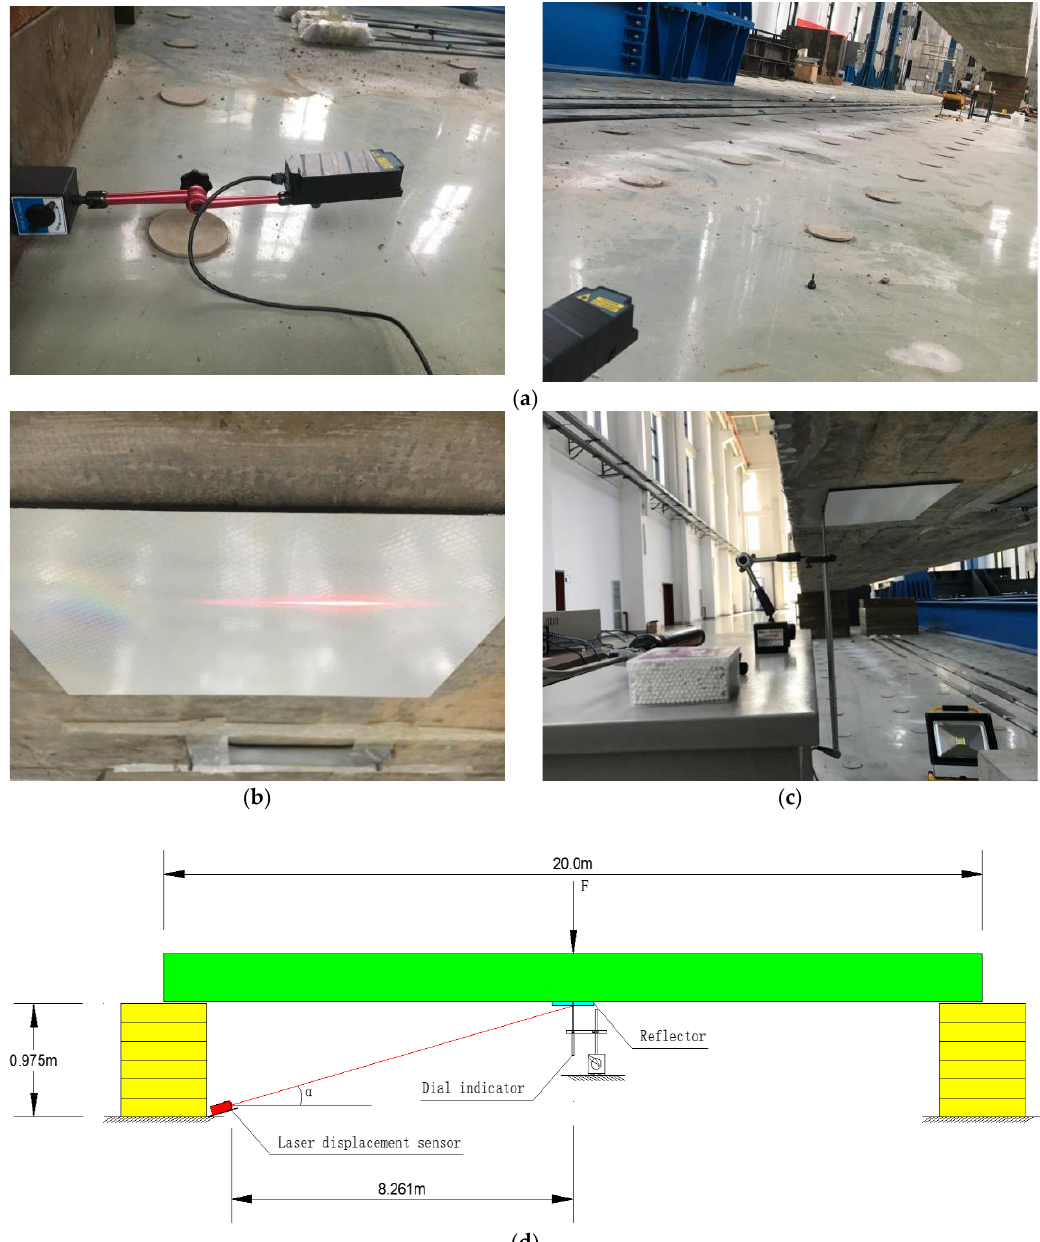
Figure 7. Test scene. ( a ) Installation of laser displacement monitoring equipment. ( b ) Microprism reflective sheet. ( c ) Dial indicator. ( d ) Schematic diagram of the experiment.